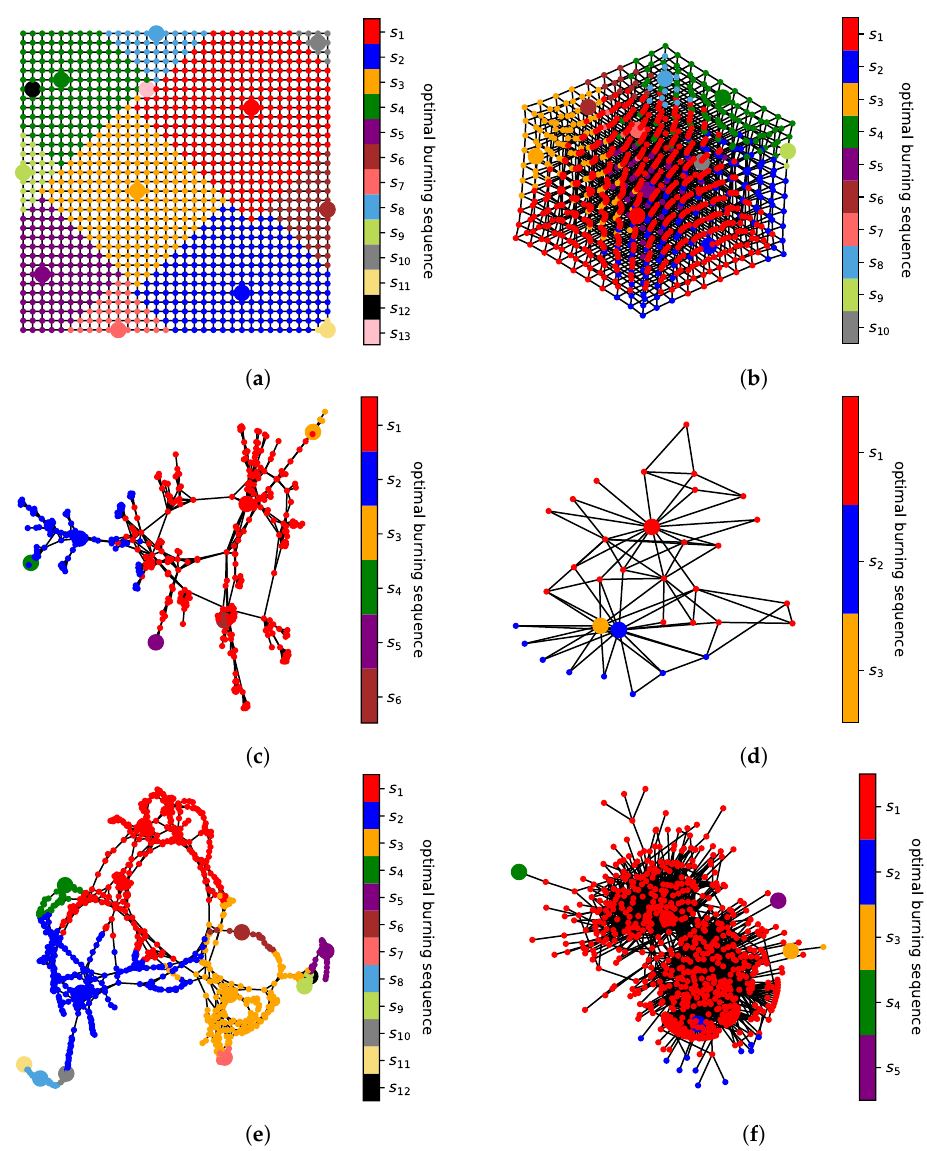
Figure 2. Optimal burning sequence ( s 1 , s 2 ,..., s b ( G ) ) of ( a ) a two-dimensional lattice, ( b ) a three- dimensional lattice, ( c ) the ca-netscience graph, ( d ) the karate-club graph, ( e ) the DD199 graph, and ( f ) the web-polblogs